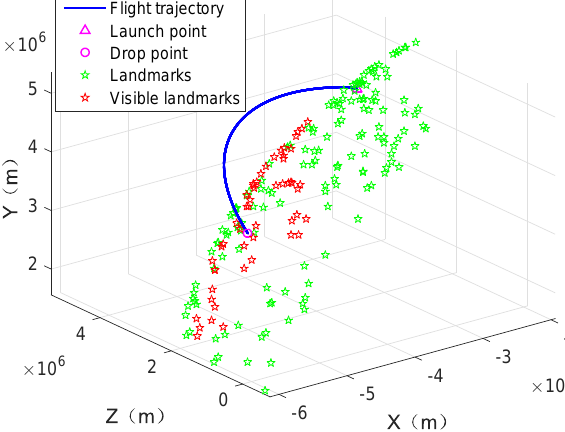
Figure 4. Simulated missile trajectory and